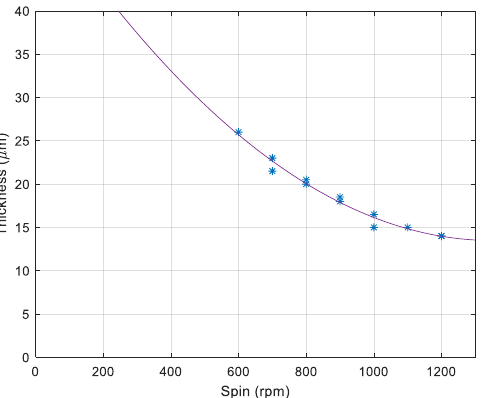
Figure 3. NOA81 foil thickness against spin-coating speeds. The curve is a quadratic fit to the data. The function equation of the curve is 𝑦 = 2.2 × 10 −5 𝑥 2 − 0.059𝑥 + 53 and the R-squared value for the fitting curve is 0.978.